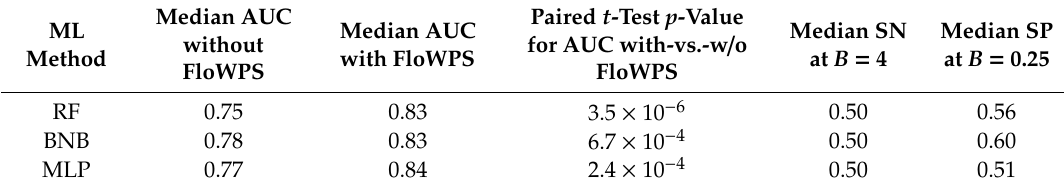
Table 2. Performance metrics for BNB, MLP and RF methods with the advanced settings for datasets with equal numbers of responders and non-responder